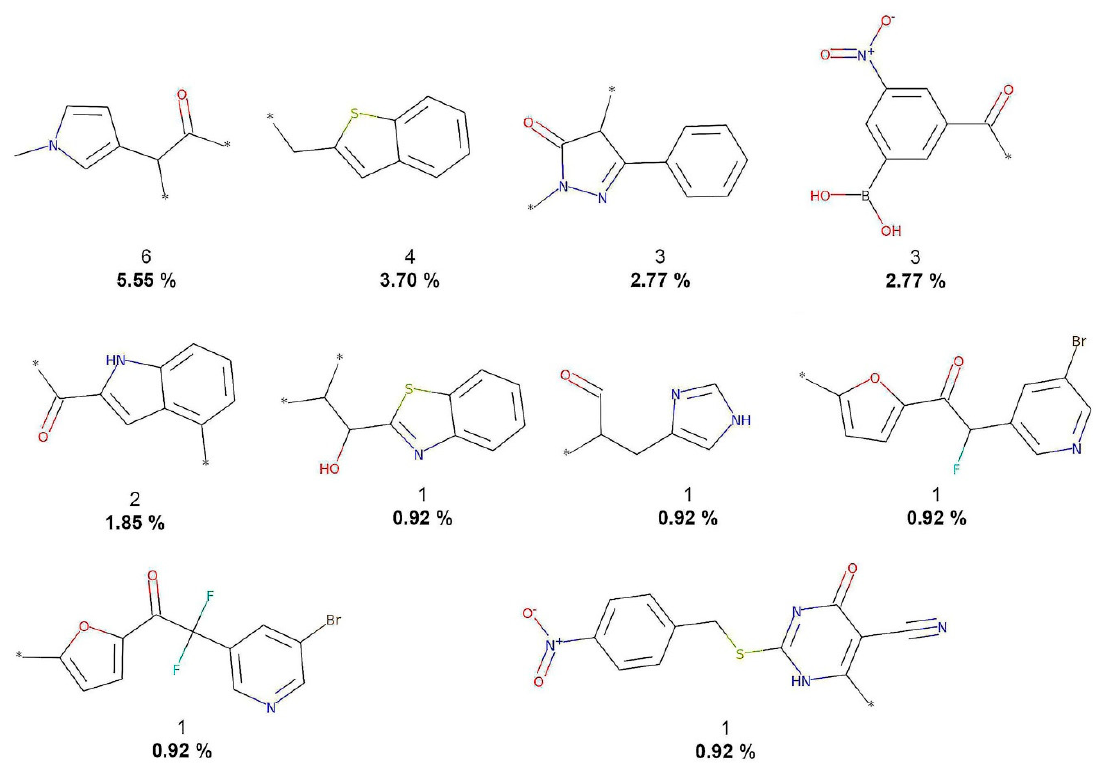
Figure 6. The 10 most frequent and unique 3CLP fragments. Frequency (regular bond) and proportion (bold font) are listed below the chemical structures.